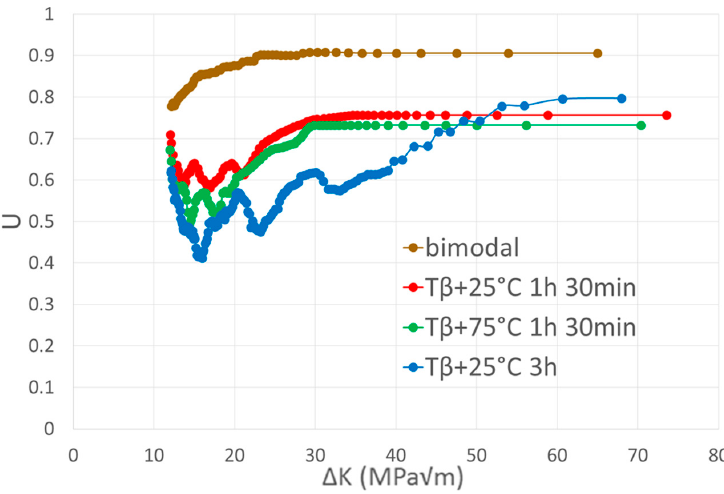
Figure 13. Crack closure measurements for three lamellar microstructures and the bimodal microstructure.